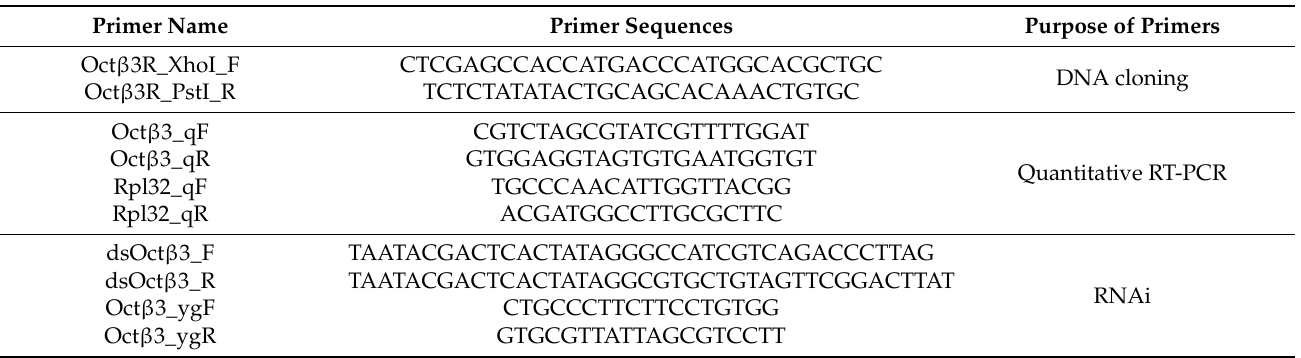
Table 1. Primers used in this